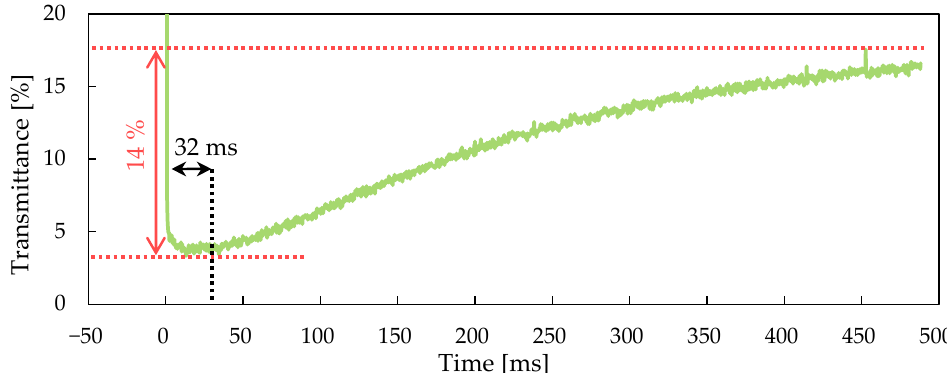
Figure 7. Change in direct optical light transmission of the PFLC light diffuser element over time after the onset of external electric field-off condition. Utilized light source: white LED.